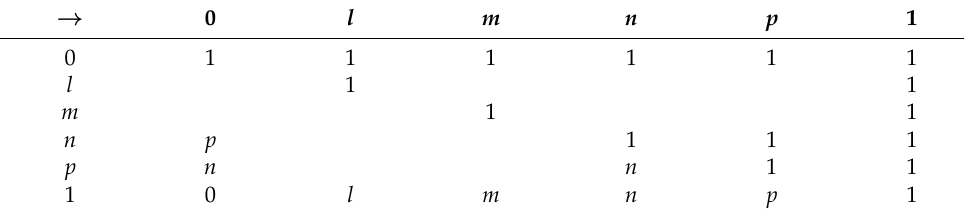
Table 16. The partial operation →